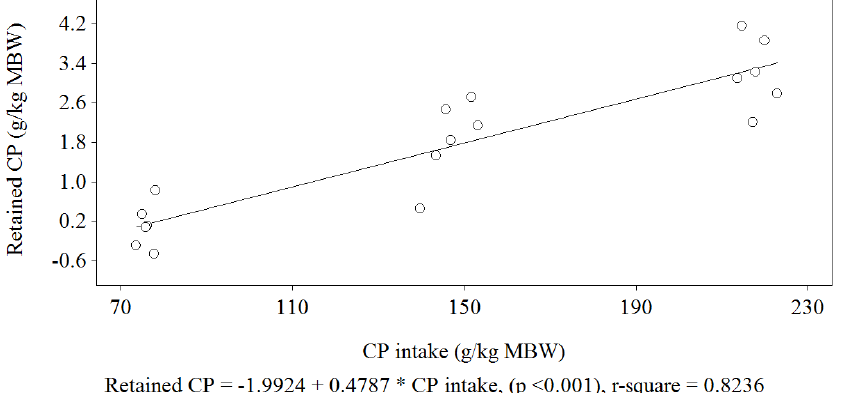
Figure 1. Regression equation of daily retained crude protein (CP) according to daily CP intake by female spotted deer (MBW = BW 0.75 ) (MBW, metabolic body weight; BW, body